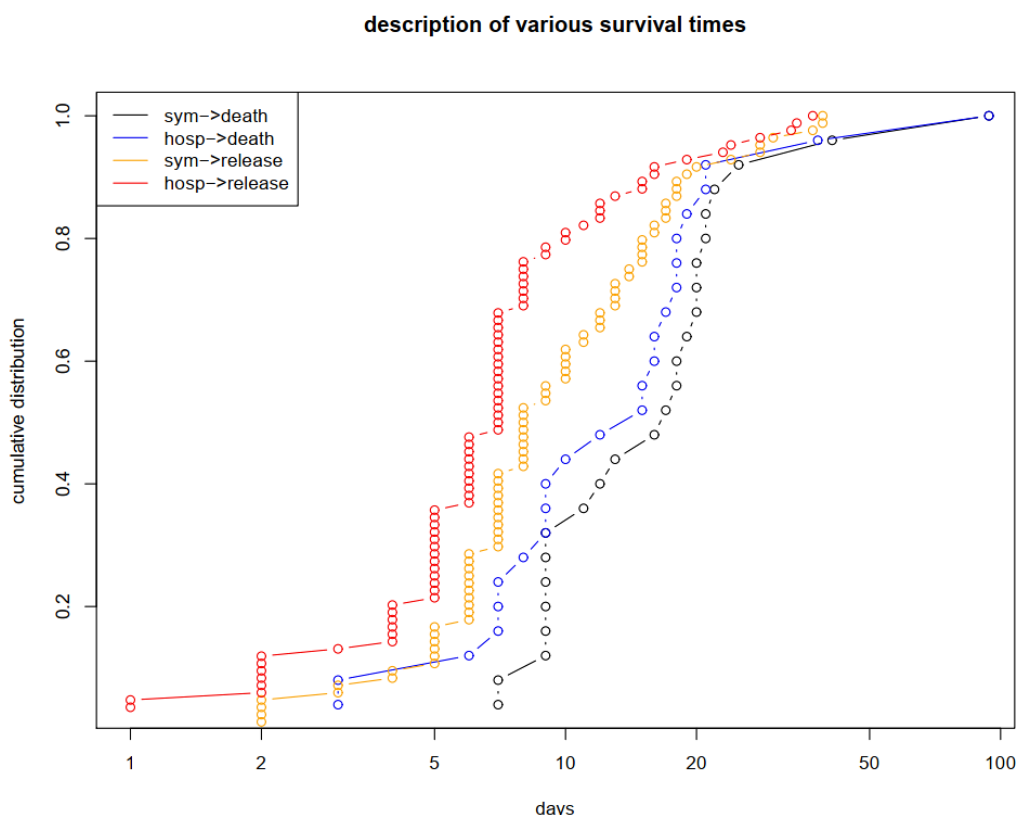
Figure 1. Cumulative distribution of four time-to-event values: symptom-to-release (orange), hospitalization-torelease (red), symptom-to-death (black), and hospitalization-to-death (blue). The number of released patients is 84 and the number of deceased patients is 25. The y-axis has a jump of 1/84 (for control group) or 1/25 (for case group) for each sample at its time- to-event value